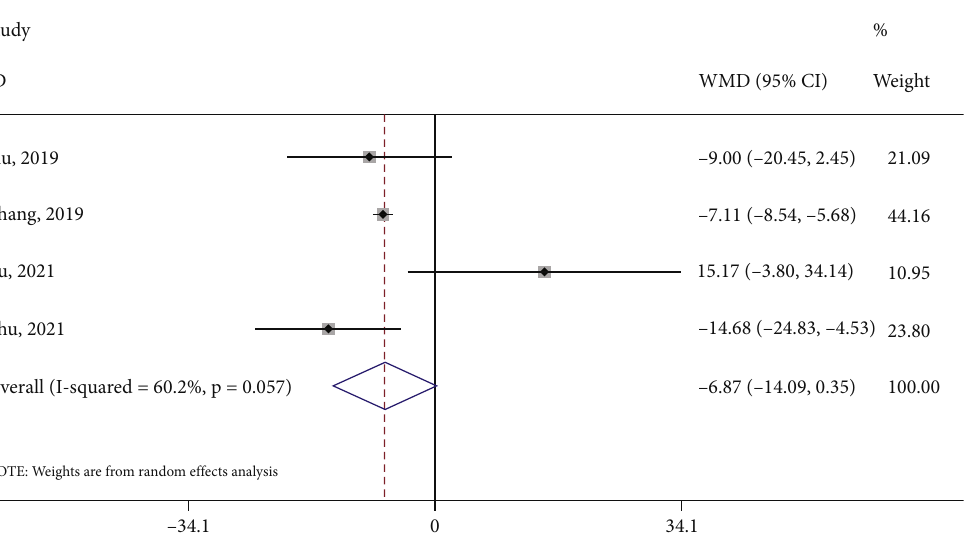
Figure 4: Forest plot of the serum